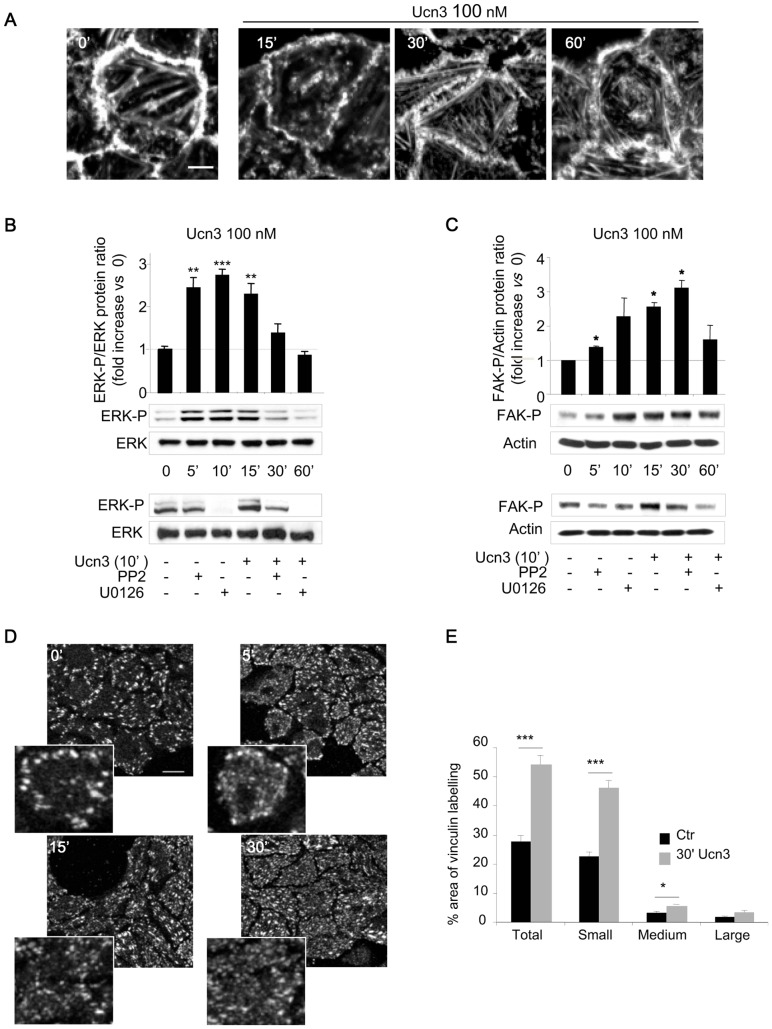
CRF2 signaling reorganizes cell-matrix contacts.(A) Phaloidin-TRITC fluorescence is analyzed by confocal microscopy at the basal pole of HT-29 CRF2-GFP cells following Ucn3 treatment. Scale bar, 5 µm. (B) ERK-PTyr204/ERK total ratio quantified from immunoblot in HT-29 cells treated with Ucn3 (0 to 60 min) (Upper panel). Effects of Src (PP2: 10 µM, 1 hr) or MEK (U0126: 10 µM, 1 hr) inhibitors on Ucn3 induced ERK-PTyr204 (Lower panel). (C) Ucn3-mediated phosphorylation of FAK- PSer910 in HT-29. Quantifications were performed from immunoblots and normalized to actin (upper panel). Effects of Src (PP2, 10 µM, 1 hr) and ERK (U0126, 10 µM, 1 hr) inhibitors on Ucn3 induced FAK-PSer910 (Lower panel). (D) Confocal analysis of vinculin distribution at the basal pole of HT-29 following Ucn3 treatment. Scale bar, 20 µm. (E) Quantification of the patch number by size at 30 min of Ucn3 treatment.